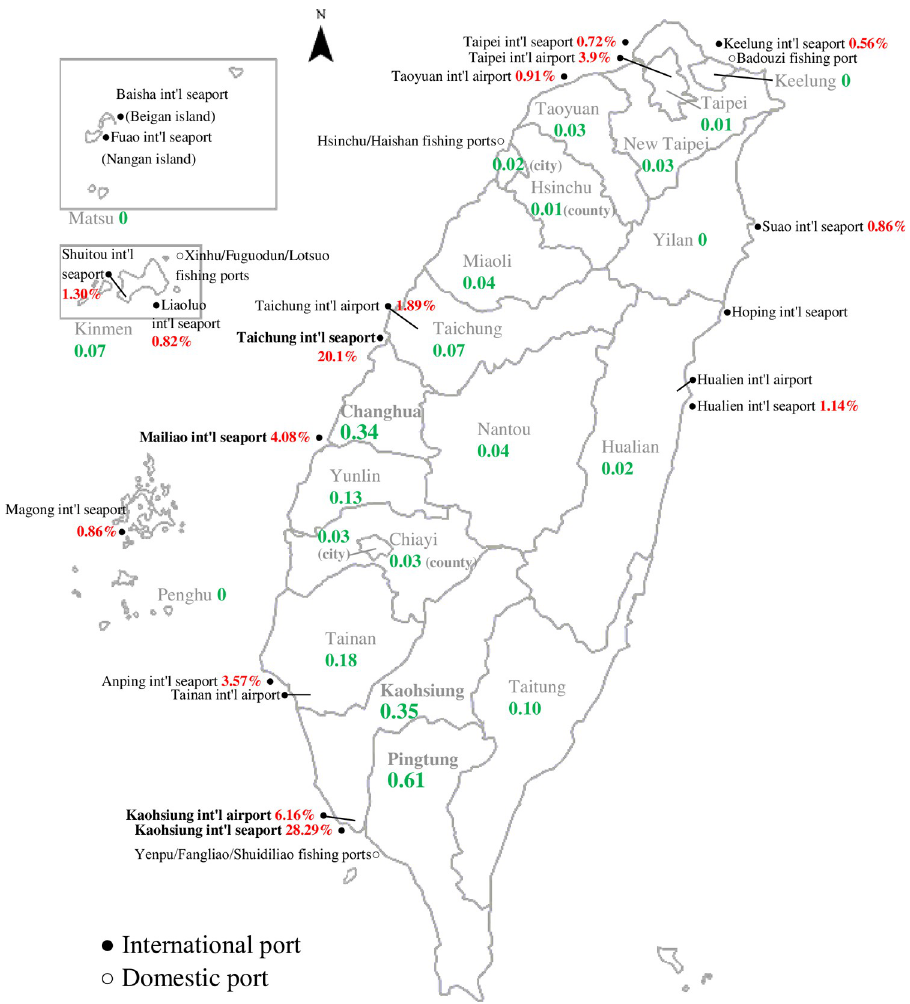
Fig 1. Administrative district and study sites for the surveillance of R . typhi infections in small mammals and indigenous cases of murine typhus infection in humans in Taiwan. The name of each administrative district is labeled in gray. International and domestic ports are labeled with solid and open circles, respectively. The seropositive rate of R . typhi in small mammals and the incidence rate (per 100,000 person-years) of indigenous murine typhus are marked with red and green, respectively. The base layer of the map was downloaded from National Land Surveying and Mapping Center of the Taiwan Ministry of the Interior, (https://maps.nlsc.gov.tw/MbIndex_qryPage.action?fun=